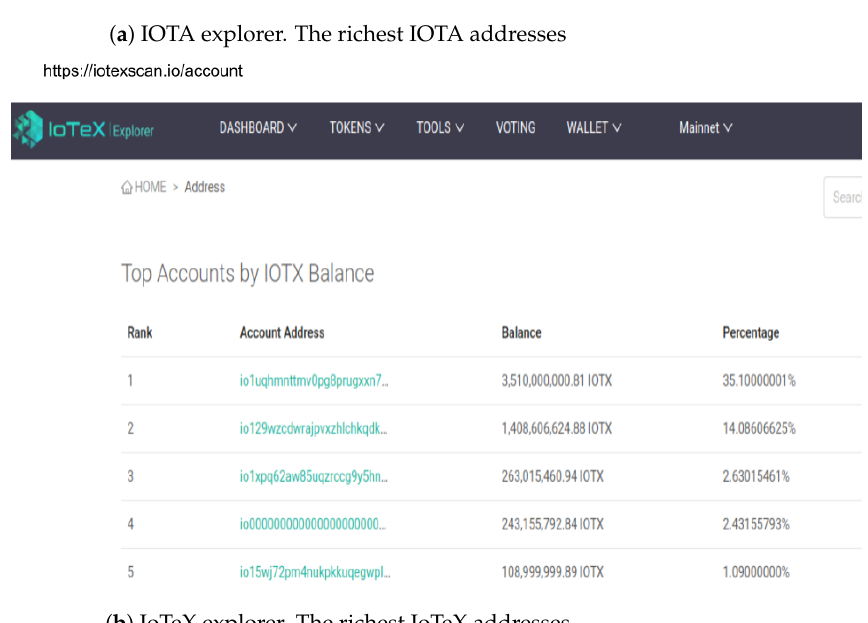
Figure 3. IOTA and IoTeX ledger explorers.